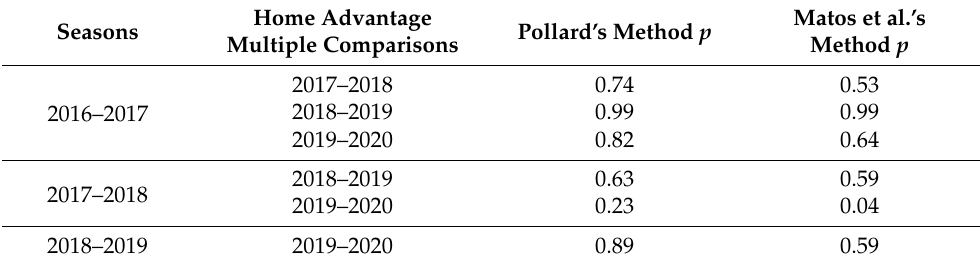
Table 4. Differences in home advantage in Portuguese Football League across 2016–2017